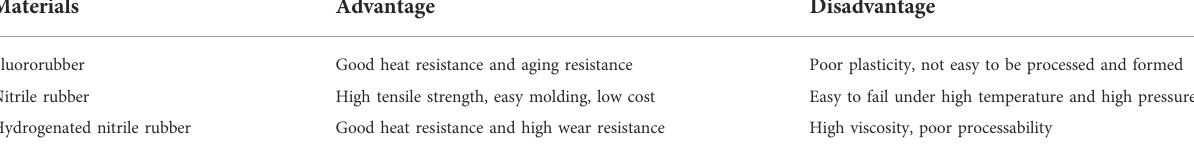
TABLE 1 Comparison of properties of different types of rubber materials.